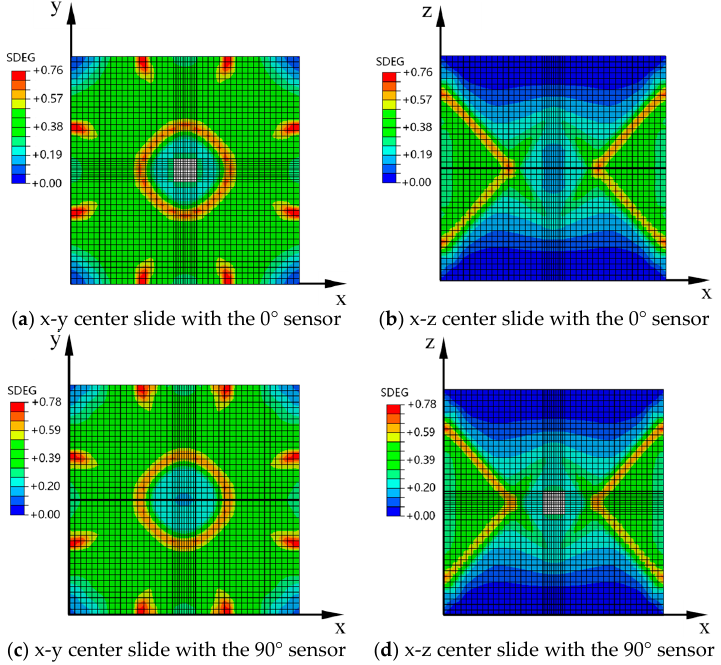
Figure 10. Numerical conductance signatures of the ( a ) 0 ° flat, ( b ) 90 ° flat, ( c ) 0 ° rough , and ( d ) 90 ° rough PZT sensors embedded in concrete cubes under inelastic deformation.